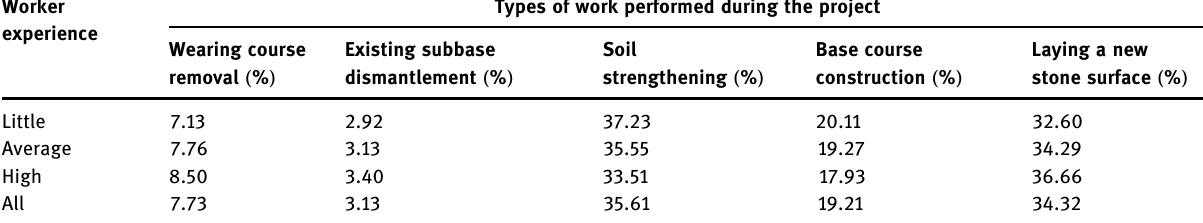
Table 8: Percentage share of the average cost of each stage relative to the average overall project cost for various worker experience ratings ( little; average; high ) Worker